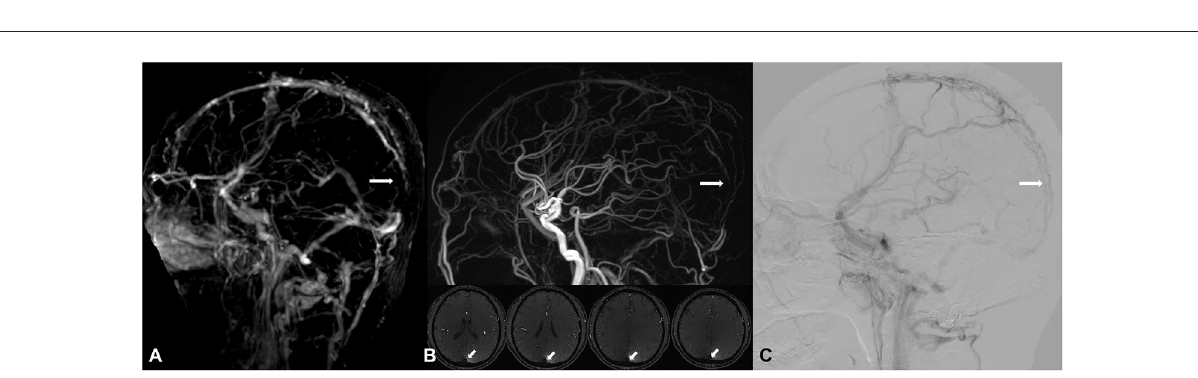
FIGURE5 A 51-year-old male, suffered from headache, received interventional therapy for DAVF 5 months ago. Residual DAVF in the superior sagittal sinus was diagnosed, with attendant thrombosis (white arrow) found by DISCO-MRA [lack of signal in the DISCO-MRA venous phase (A) ] and TOF-MRA [hypointensity in the TOF-MRA slice and reconstructed image (B) ], and confirmed by DSA [filling defect in DSA venous phase (C)